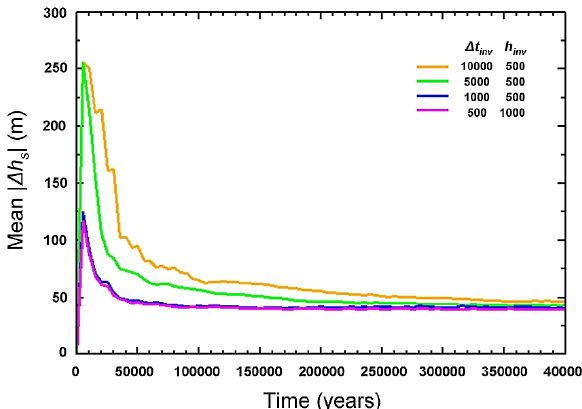
Fig. 4. Time series of mean absolute surface elevation error (model vs. observed | 1h s | , m) in inverse runs with sub-grid topographic influence, for various combinations of 1t inv (time interval between adjustments, yr) and h inv (scaling constant, m) in Eq.